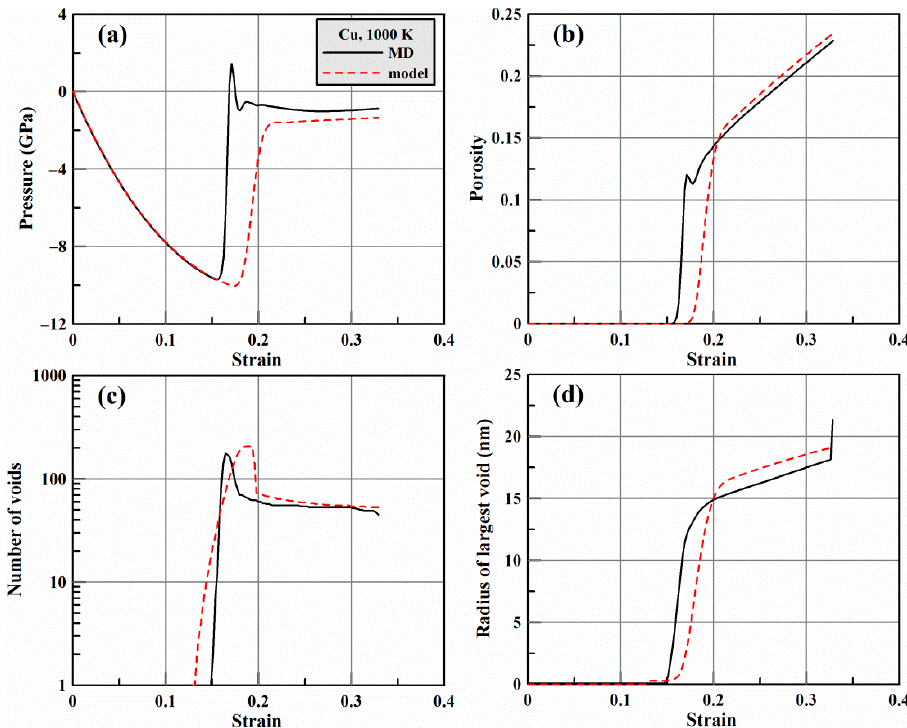
Figure 6. Comparison of the model and MD data for the case of uniform copper at 1000 K: Evolution of ( a ) pressure, ( b ) porosity, ( c ) number of voids, and ( d ) radius of the largest void.